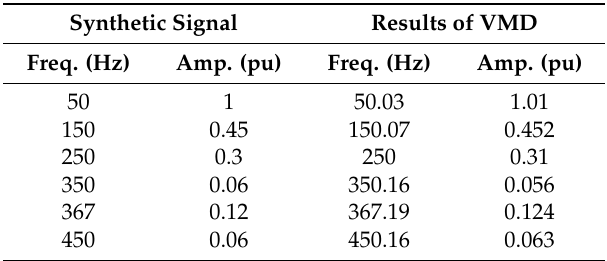
Table 1. Results of variational mode decomposition (VMD) for harmonics and interharmonics extraction.